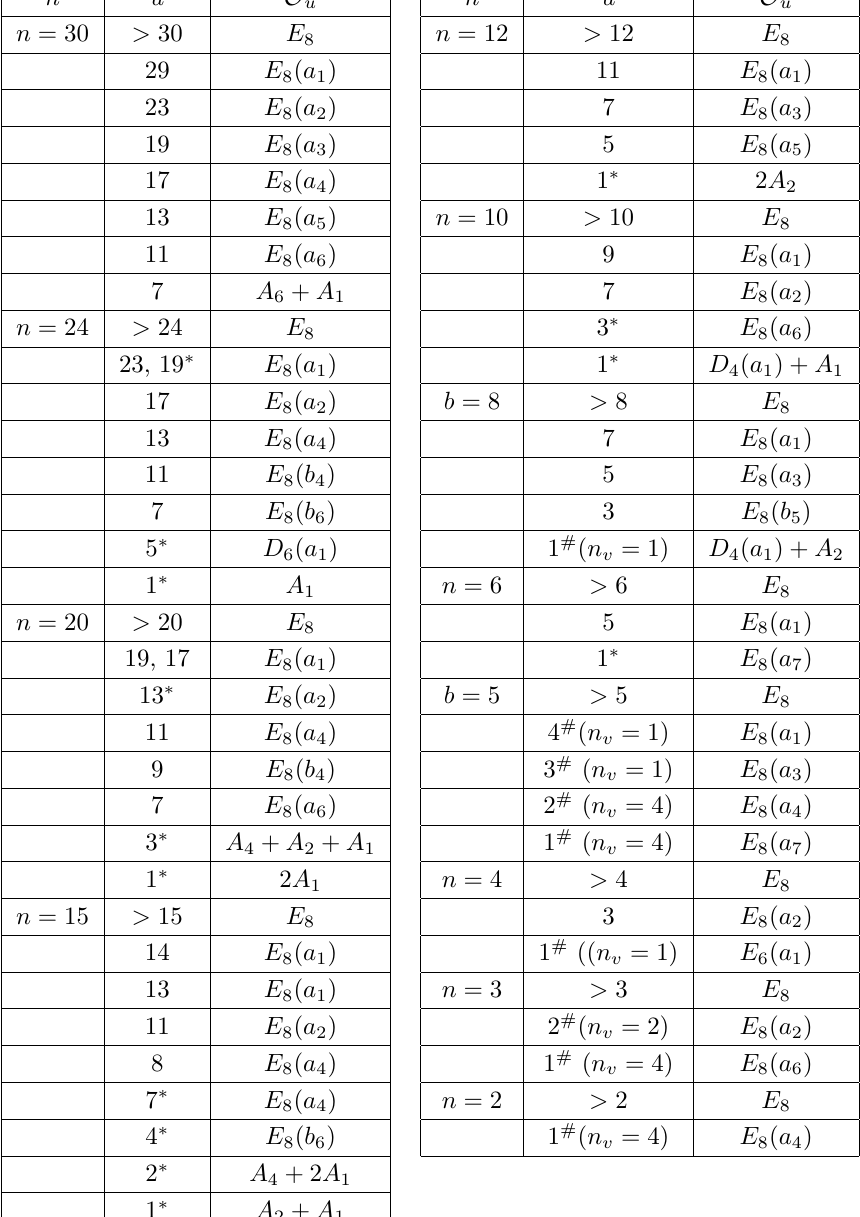
Table 22 . Associated variety for E 8 type AKM. The rank of the Coulomb branch is: r = 120 The one with star implies that the theory has a pure Higgs branch. The one with # implies that the IR theory in the Higgs branch has free vector multiplets, and n n = 24 , u = 5 , there are actually two possible choices of nilpotent orbits ( D 6 ( a 1 ) and A 6 ) which satisfy our formulas (7.9) and (7.13) (with n